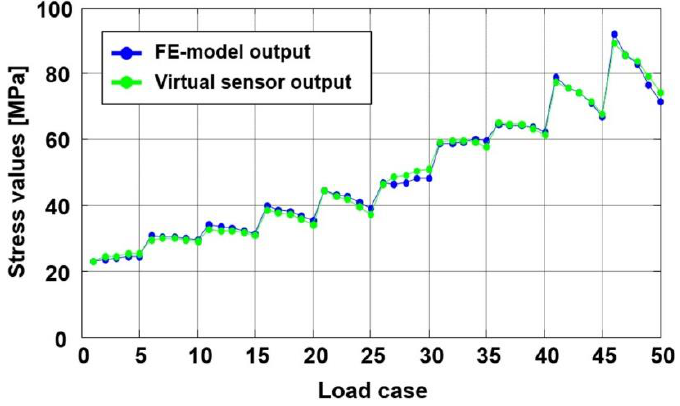
Figure 7. Comparison of virtual sensor output to output of FE model.